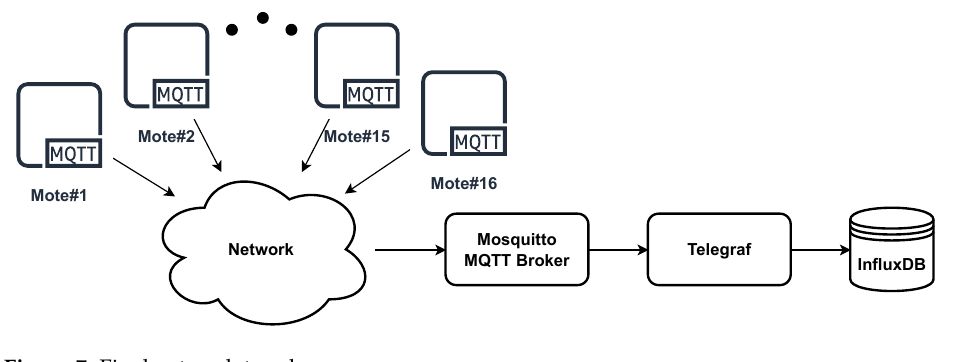
Figure 7. Final network topology.